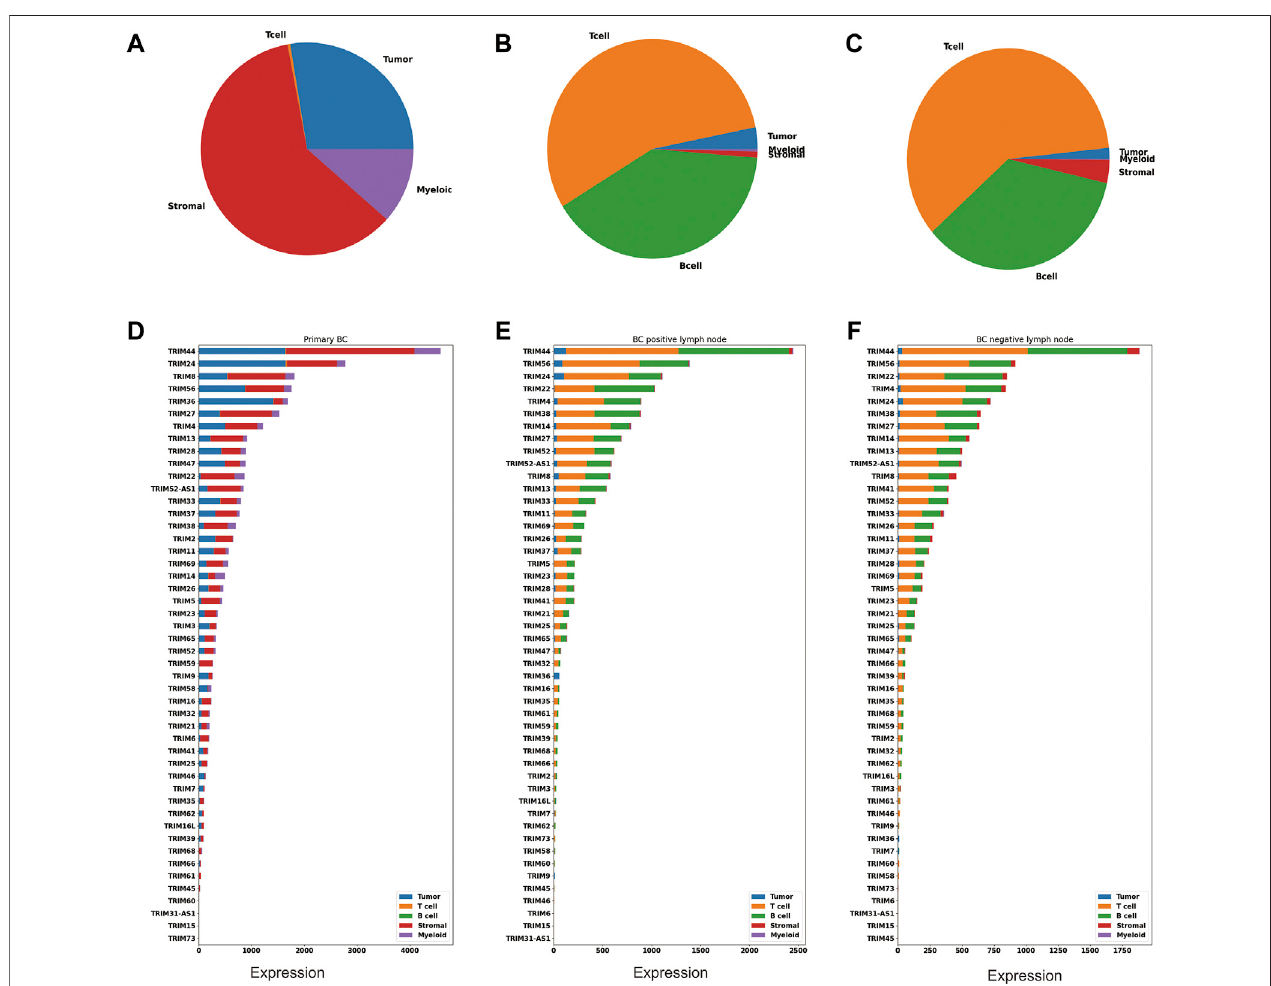
FIGURE4| Cell-typeexpressionspeci fi cityofTRIMsinBC.Pieplotsshowingthepercentageofthetumor,myeloid,stromal,B,andTcellsin (A) theprimarytumor, (B) the positive lymph node, and (C) the negative lymph node using GSE158399. Bar plots showing the expression of TRIMs in different cell types for (D) the primary tumor, (E) the positive lymph node, and (F) the negative lymph